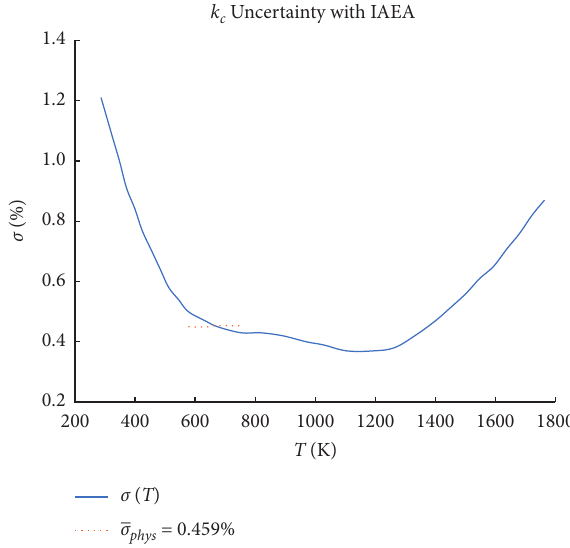
Figure 14: Cladding conductivity k the IAEA